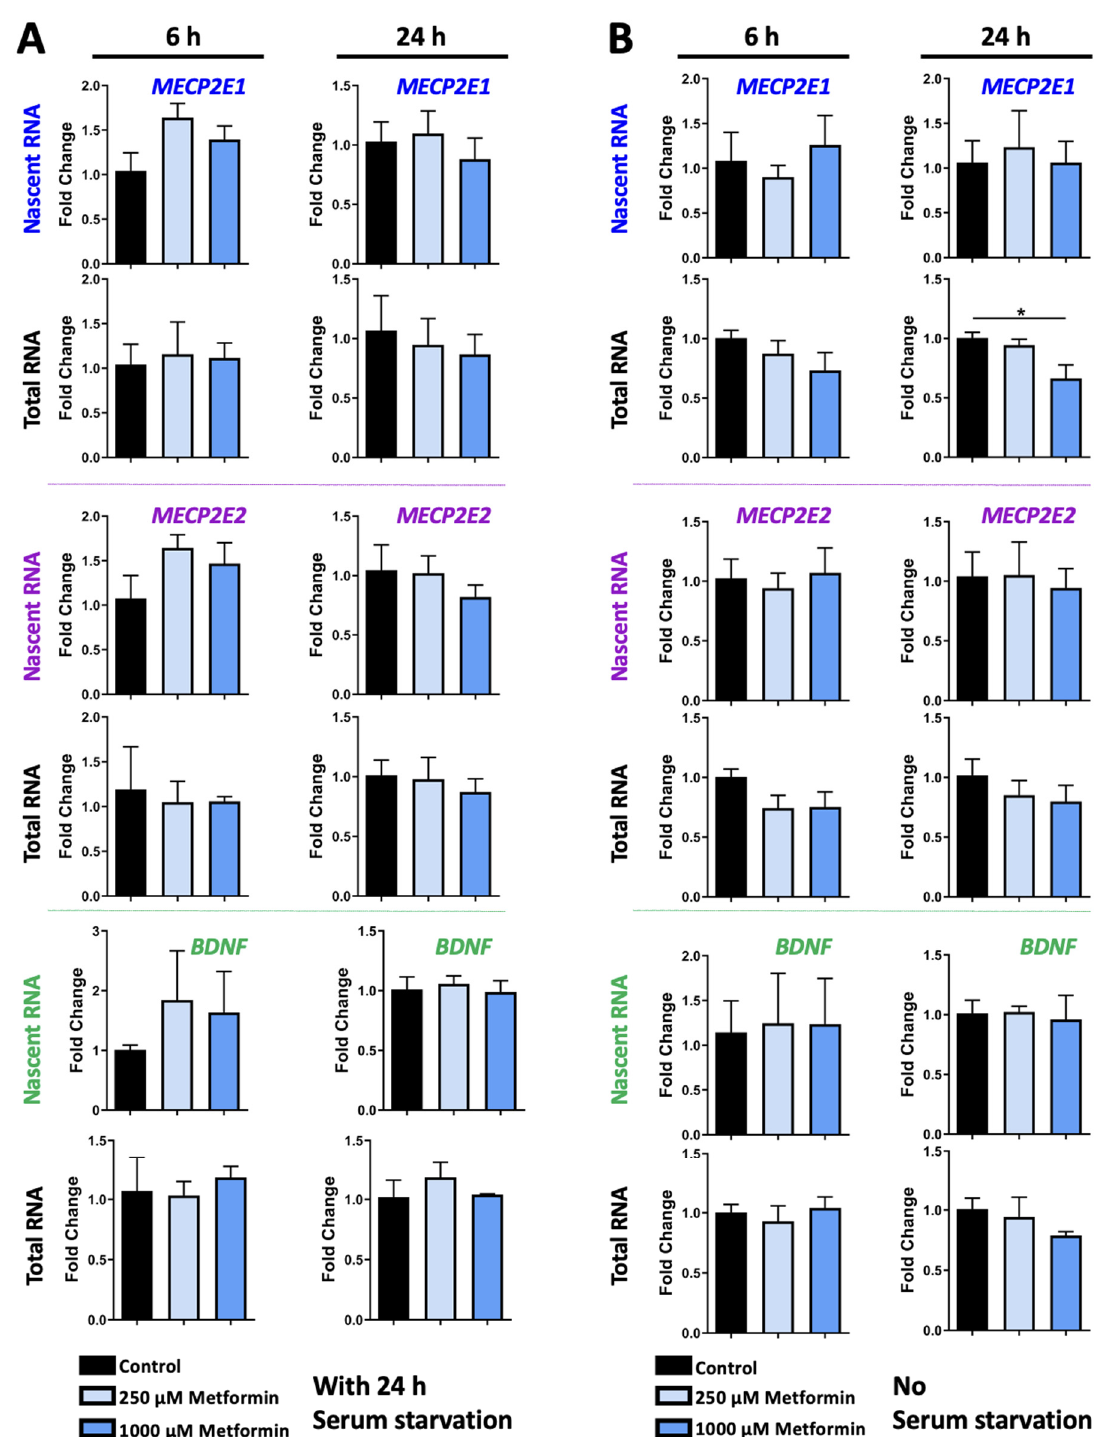
Figure 2. Transcriptional effect of metformin on MECP2E1-E2 and BDNF in Daoy cells under the condition of with and without serum starvation. ( A ) Daoy cells were serum-starved for 24 h prior to drug treatment with 250 and 1000 μ M metformin. Samples were collected at 6 and 24 h and gene-specific nascent and steady RNA transcripts were analyzed by RT-PCR for MECP2E1 , MECP2E2 , and BDNF . C T values were normalized to the housekeeping gene GAPDH and fold change was determined relative to the average control. N = 3 ± SEM. Fold change values were analyzed by one-way ANOVA followed by Tukey’s multiple comparisons test, * p < 0.05. ( B ) Similar to A, but Daoy cells were subjected to the same drug treatment, without prior serum starvation.